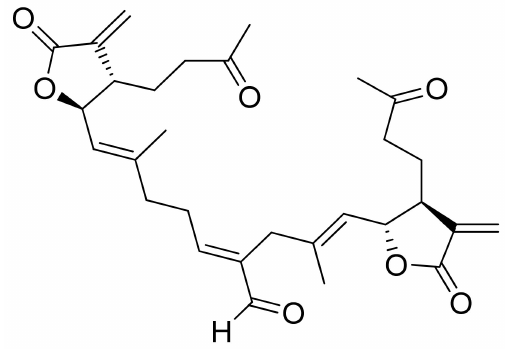
Figure 10. Kaunial. Two C-11 terpene lactones (loliolide and isololiolide) were isolated from Heliotropium bac- ciferum Forssk. Their cytotoxicity was verified in the HCT116 (human colon cancer) and DLD1 cell lines. Both lactones showed IC 50 values ranging from 0.306 to 0.351 mM in HCT116 cells and between 0.236 and 0.395 mM in DLD1 cells [37]. A wider group of lactones from the genus Sinularia proved to have cytotoxic activity rather than an- timicrobial activity [16]. Both flexibilide and sinulariolide (Figure 2) are cytotoxic [38]. In vitro, sinulariolide was tested against the human KB, A-549, HT29, and P388 cell lines. The results were 7.6 µ g/mL, 3.0 µ g/mL, 3.1 µ g/mL, and 3.9 µ g/mL, respectively [39]. The same lactones as those from the antimicrobial test were evaluated by the Villarreal group against the KB, P388, and KBVI (vinblastine-resistant KB) cell lines. Lactones from the germacrolide and heliangolide groups were active against all of the cells, whereas eu- desmane was moderately active against P388 cells [15]. Pawlak and colleagues synthesized two trans - β -aryl- δ -iodo- γ -lactone isomers from 2,5-dimethylbenzaldehyde and tested their cytotoxicity against CLB70 (chronic lymphoid leukemia), GL1 (acute canine lymphoid leukemia), and Jurkat (acute human lymphoid leukemia) cells. Both isomers showed 80% dead cells after treatment with 50 µ g/mL solution, although the dextrorotatory isomer was more potent. Apoptosis was induced by a classic caspase-dependent pathway. Inhibition of two anti-apoptotic proteins (Bcl-xL and Bcl-2) was observed. Canonical apoptotic cell death was connected with phosphatidylserine exposure and caspase 3/7 activation. A decrease of the presence of anti-apoptotic proteins is followed by the activation of caspases and cleavage of PARP in the nucleus [40]. The antiproliferative activities of synthetic lactones towards similar cells, D17 (canine osteosarcoma cells) and CLBL1 (a canine B-cell lym- phoma cell line) were tested by Gładkowski et al. Both stereoisomers of several compounds were evaluated, and the results showed that the trans -isomers were more active. The best results were obtained for ( − )- trans -(4 S ,5 R ,6 S )-5-(1-iodoethyl)-4-(benzo[d][1 (cid:48) ,3 (cid:48) ]-dioxol-5 (cid:48) - yl)dihydrofuran-2-one with IC 50 values of 5.29 ± 0.31 µ g/mL (Jurkat), 16.65 ± 2.56 µ g/mL (D17), 5.08 ± 0.41 µ g/mL (GL1) and 9.10 ± 0.96 µ g/mL (CLBL1). Additionally, significant results were obtained for two other compounds, ( − )- trans -(4S,5R,6S)-5-(1-iodoethyl)-4- (2 (cid:48) ,5 (cid:48) -dimethylphenyl)dihydrofuran-2-one and its dextrorotatory form, with IC 50 values ranging from 4.76 ± 0.52 µ g/mL to 16.99 ± 4.88 µ g/mL [41]. In his earlier study, other cytotoxic lactones emerged (Figure 11). Iodolactone (Figure 11a) displayed 83.7 ± 5.7% (Jurkat) and 35.2 ± 9.6% (D17) dead cells. Bromolactone (Figure 11b) resulted in 51.1 ± 8.9% (D17) and 47.6 ± 6.4% (Jurkat) dead cells